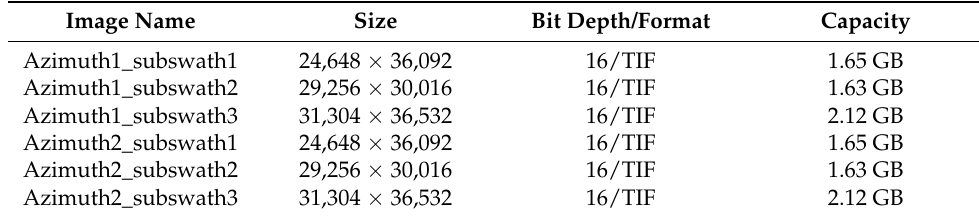
Table 3. Parameters of the six GF-3 ScanSAR images.